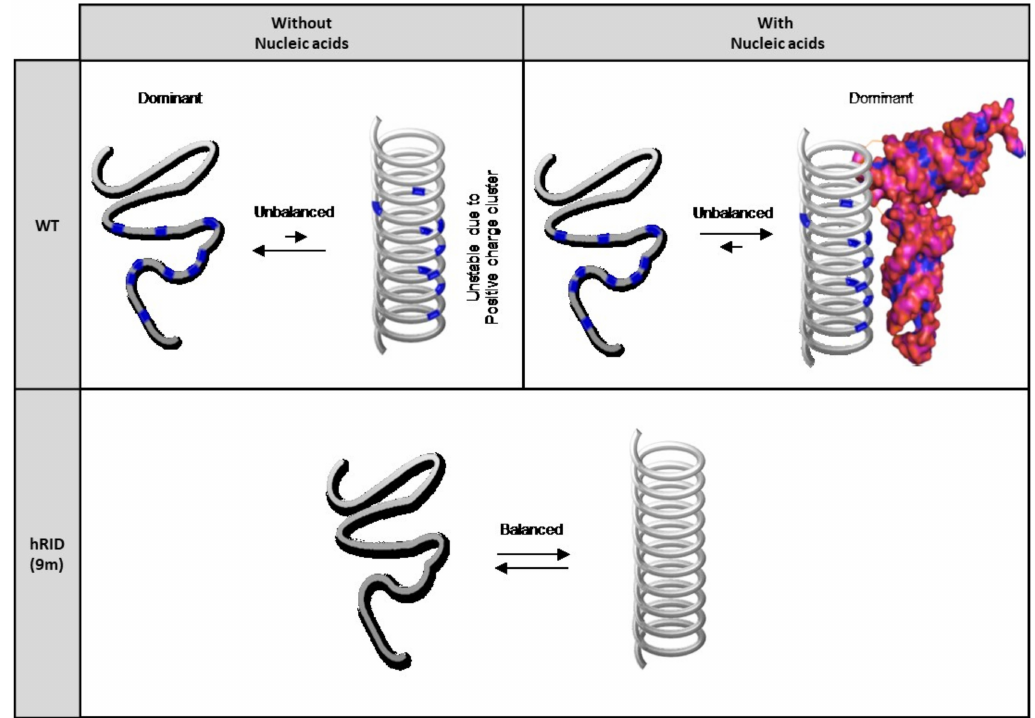
Figure 6. Diagram representing the structural equilibrium of WT and hRID(9m). WT hRID has an unbalanced equilibrium state. Intrinsically, WT has a disordered structure, which turns helical upon NA binding. However, hRID(9m) has a balanced equilibrium state regardless of the presence of